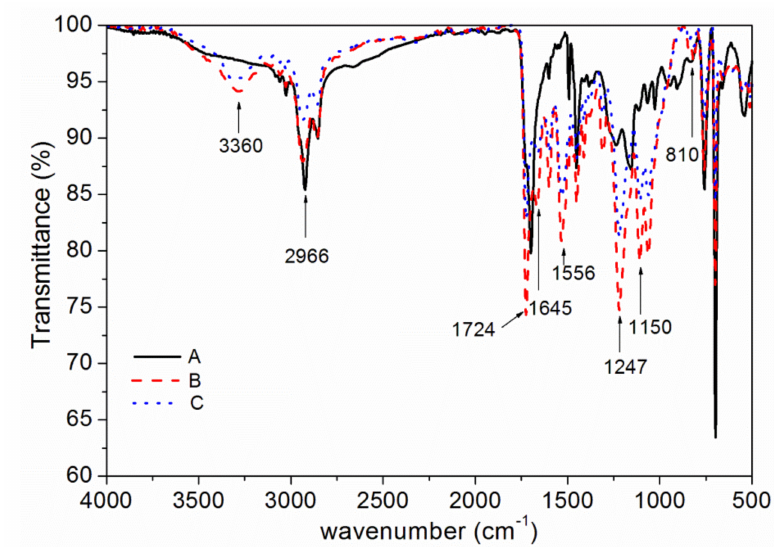
Figure 4. The influence of the mass ratio and the concentration of microcapsule on the waterborne coatings. ( A ) waterborne coatings. The mass ratio of core to wall materials was 0.83:1, the concentration of microcapsule was 5.0% ( B ) and 25.0% ( C ), respectively.